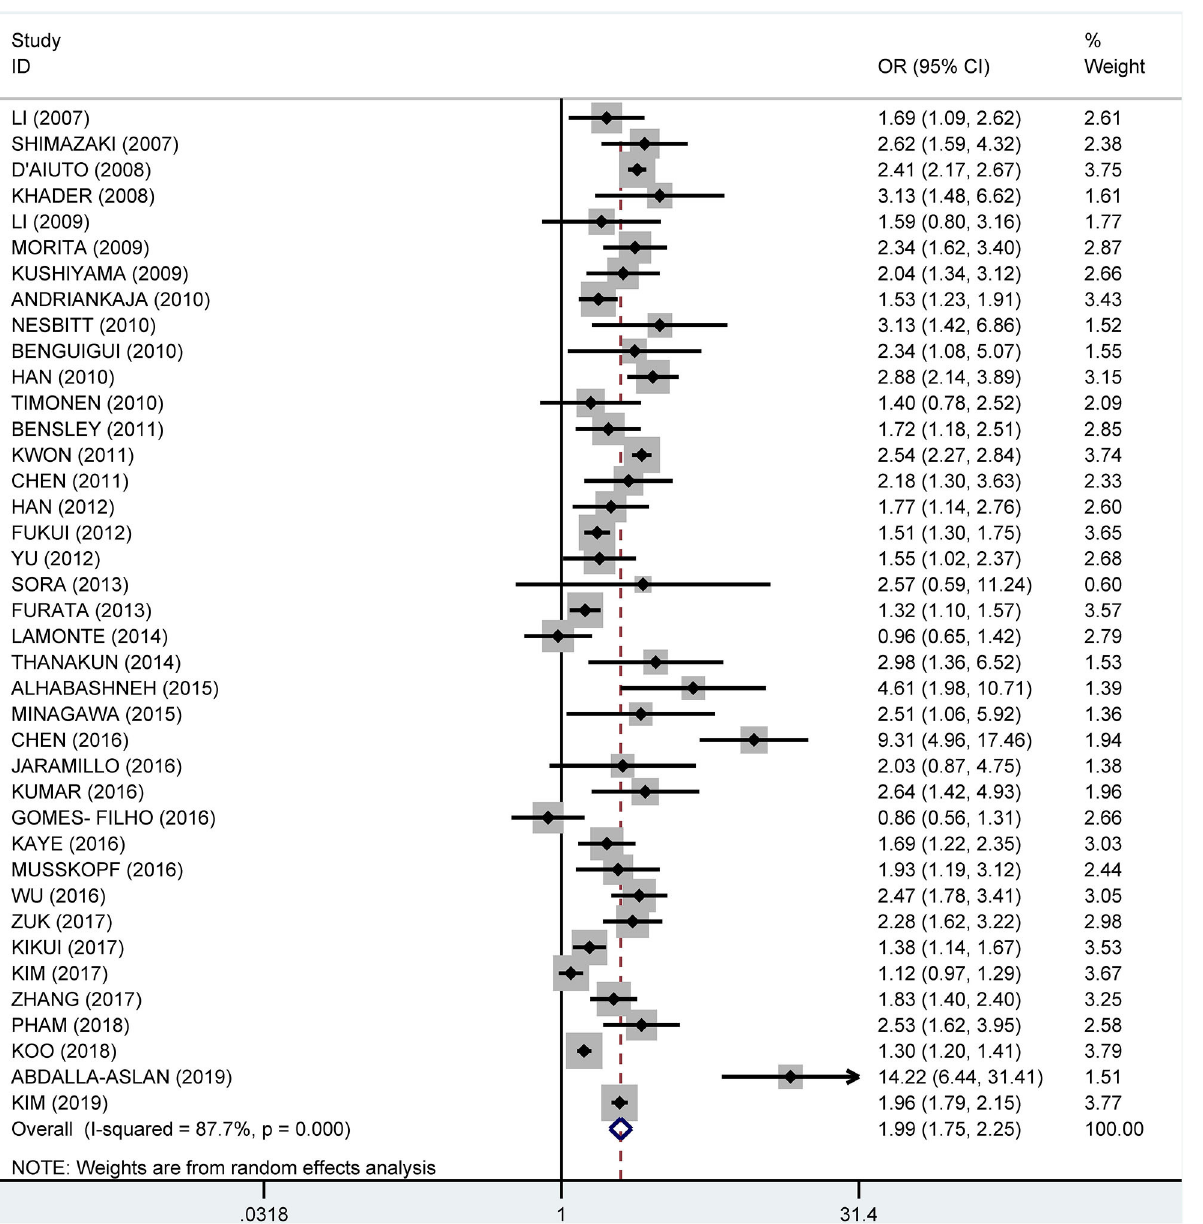
Frontiers in Endocrinology |